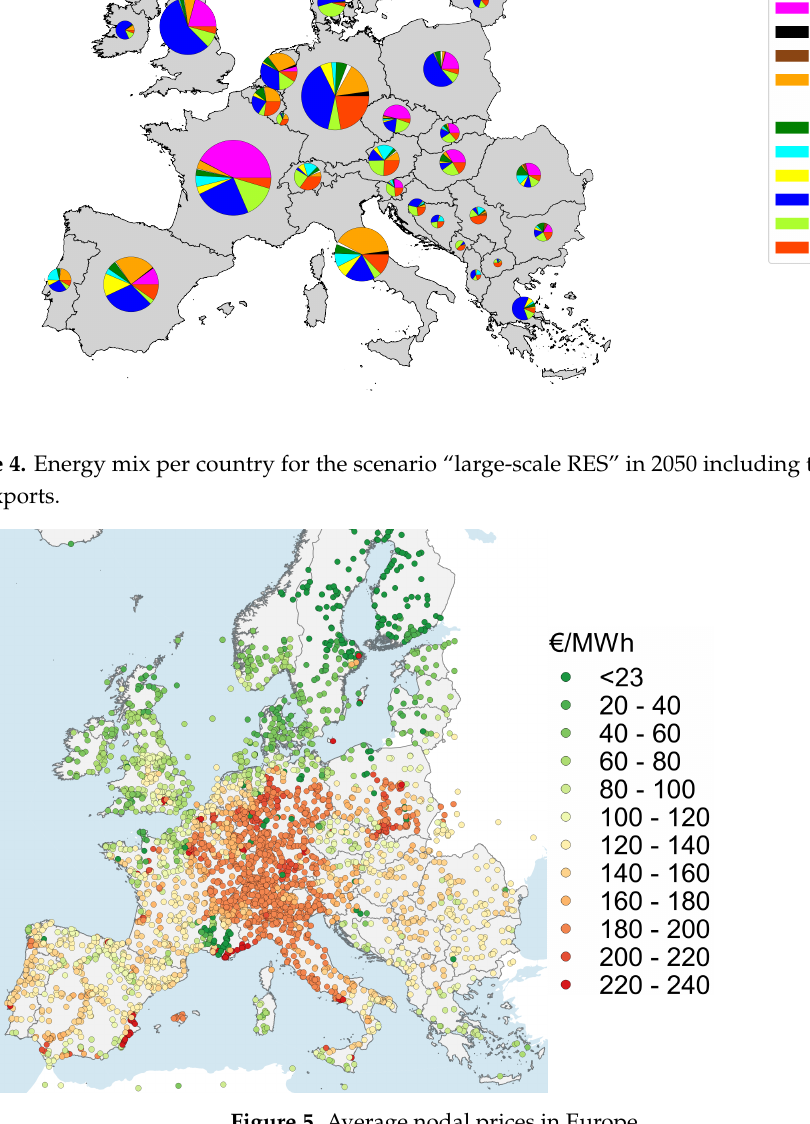
Figure 5. Average nodal prices in